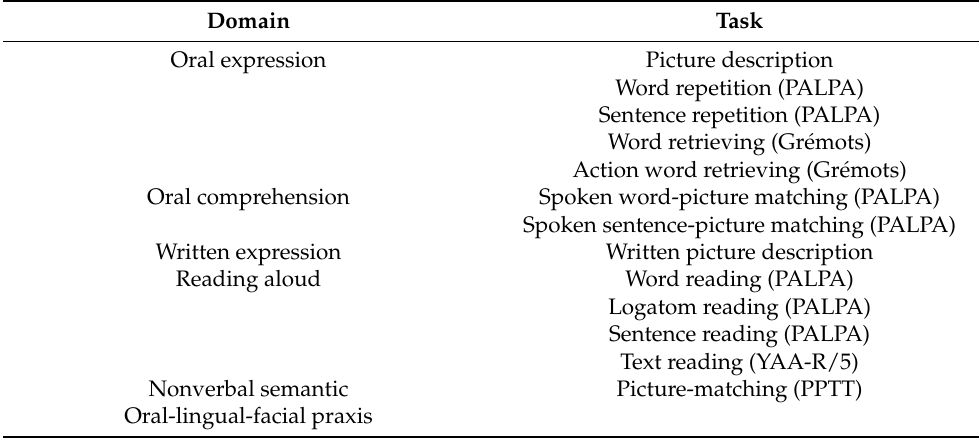
Table 1. Language evaluation.